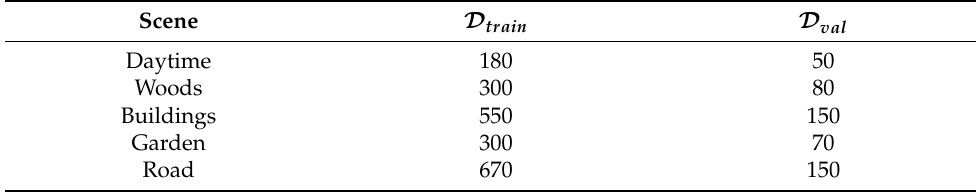
Table 1. The distribution of D train